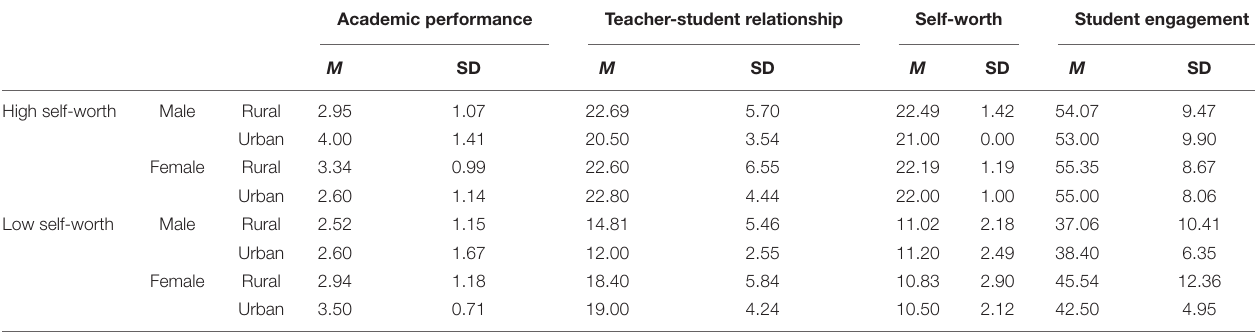
TABLE 2 | Descriptive statistics for control and dependent variables among high and low